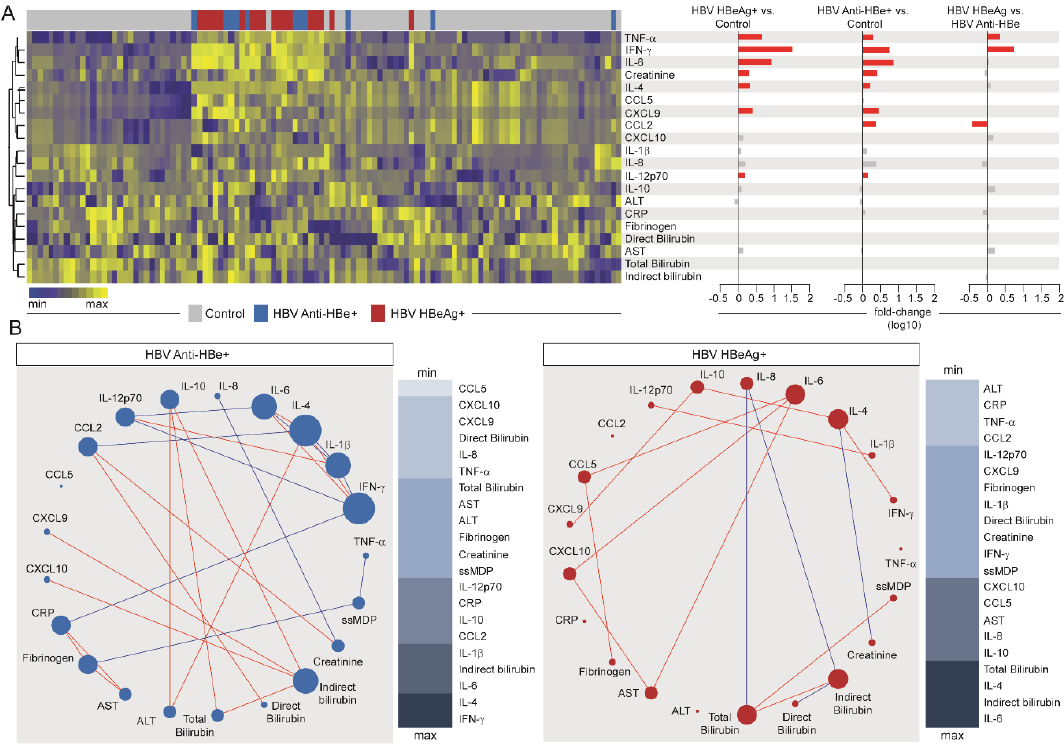
Figure 4. Effects of HBV viral replication on systemic inflammation. ( A ) Left panel: A hierarchical analysis (Ward’s method) was employed to describe the overall expression pattern of plasma biomarkers in the study groups. Dendrograms represent Euclidean distance. Right panel: Fold-di ff erences in plasma levels of the indicated biomarkers between the study groups. Di ff erences that reached statistical significance after adjustment for multiple comparisons (adjusted p < 0.05) are represented in colored bars. ( B ) Spearman correlation matrices of the MDP score values in each study group were built and Circos plots were used to illustrate the correlation networks. Only significant correlations ( p -value < 0.05) are shown. Each circle represents a di ff erent plasma parameter and the size of each circle is proportional to the number of significant correlations. Lines represent the Spearman rank (rho) values. Red color infers positive correlation, whereas blue color denotes negative correlation. Node analysis heatmap shows the number of statistically significant correlations involving each marker per clinical